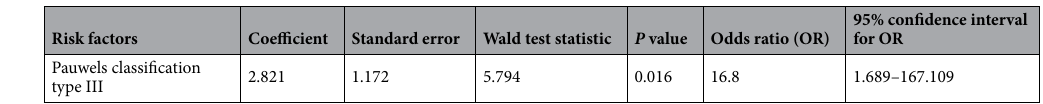
Table 7. The multivariate logistic regression analysis of the risk factors for screw cut-out.